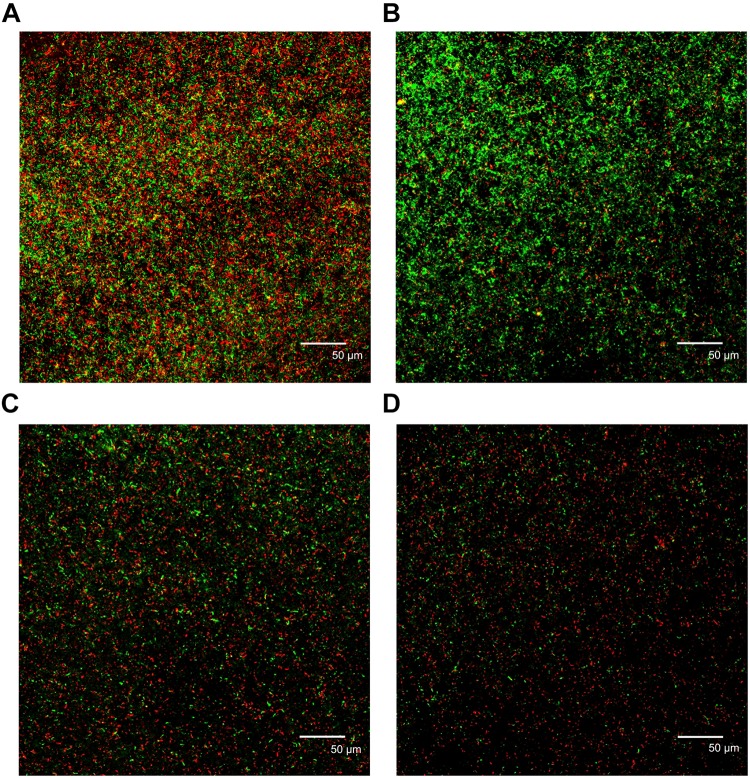
Confocal laser scanning micrographs of biofilms with different concentrations of cinnamaldehyde. (A) Control; (B) 125 μg/mL; (C) 250 μg/mL; (D) 500 μg/mL. Red, non-viable cells; green, viable cells; yellow, overlap of non-viable and viable cells. Bar = 50 μm.